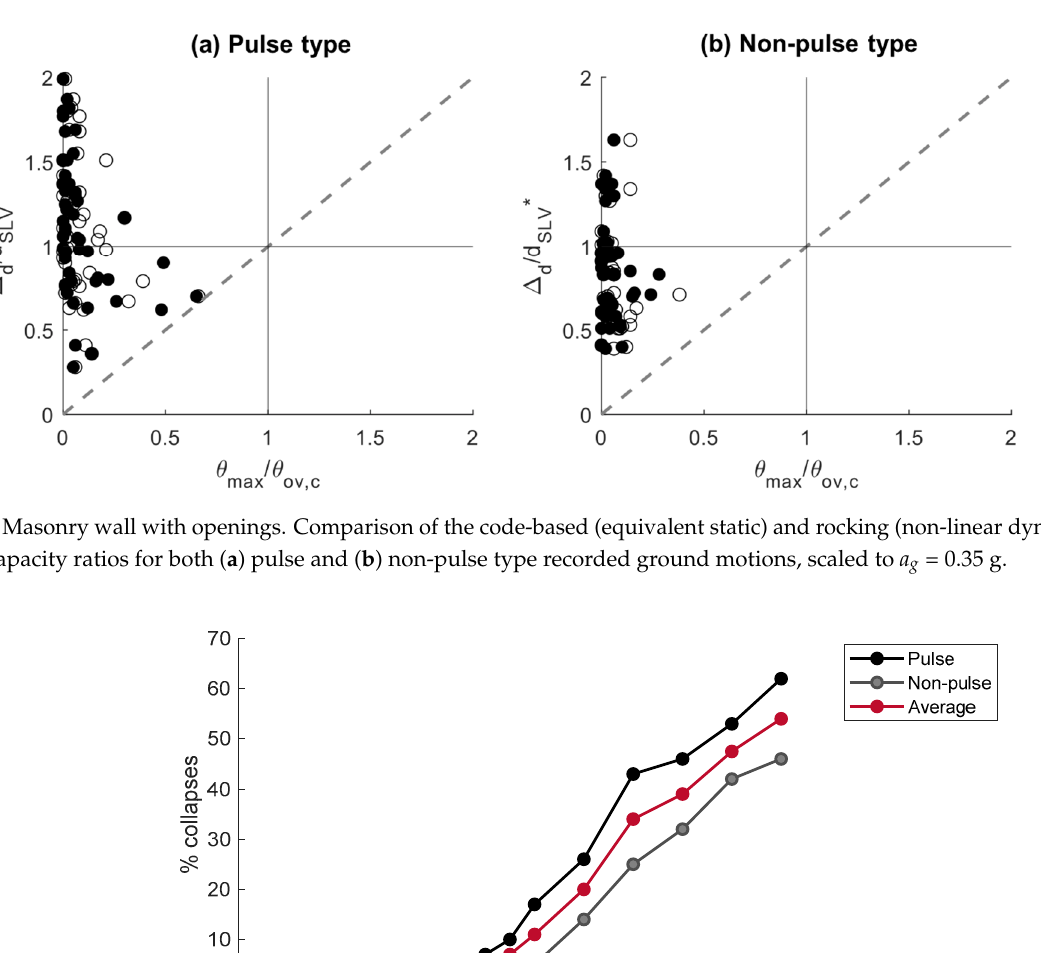
Table 5. Church. Equivalent rocking parameters calculated by the GhPython script.